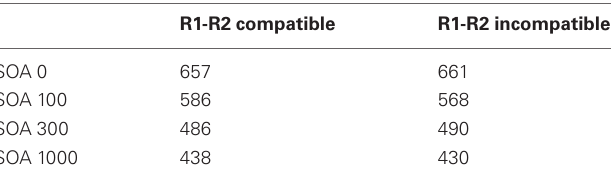
Table 1 | Reaction times in milliseconds (ms) of Task 2 of the joint condition for R(esponse)1-R(esponse)2 compatible trials and R1-R2 incompatible trials for different stimulus onset asynchronies